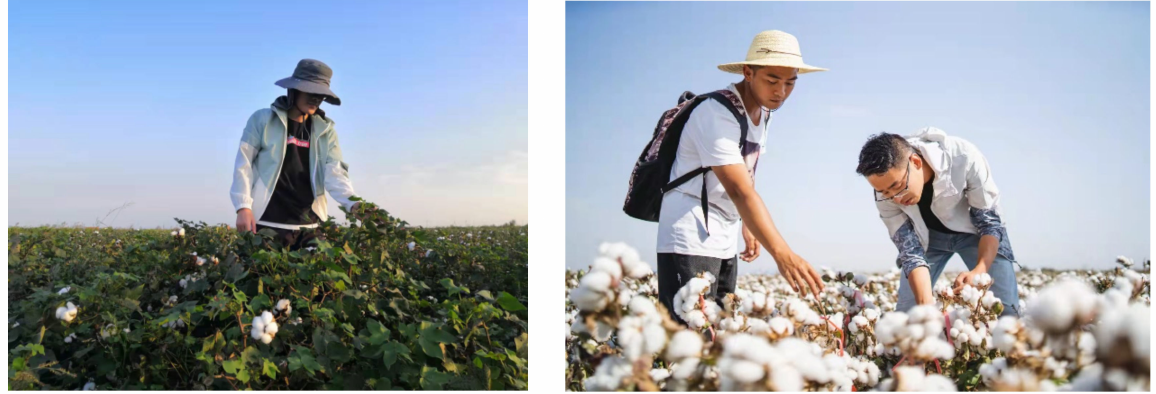
Figure 2. Ground survey of cotton defoliation